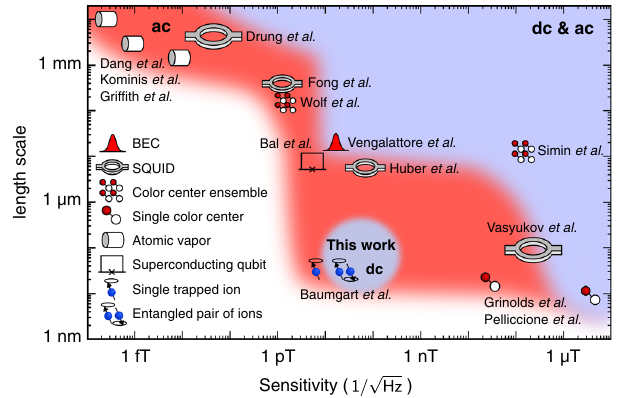
FIG. 8. Overview of recently developed magnetic-field sensors in a size-sensitivity diagram [2,3,5,6,9 – 11,14 – 16,20,21,24,60]: The shaded area represents the accessible regime for dc and quasistatic < 1 Hz (blue) or ac (red) fields. The regime for dc sensing is substantially extended by this